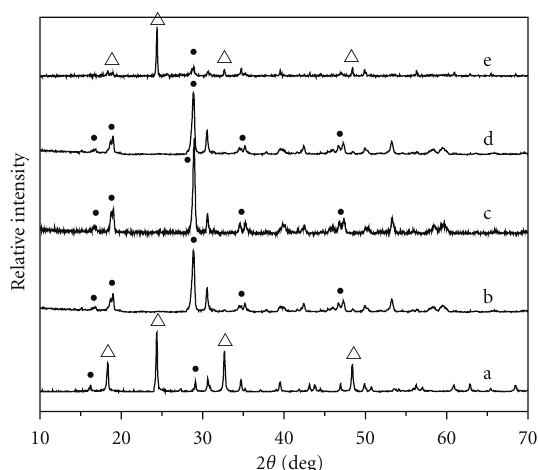
Figure 2: XRD patterns of samples under di ff erent pH. ( (cid:3) — tetragonal zircon type, • —monoclinic scheelite type). (a) pH = 1.0, (b) pH = 3.0, (c) pH = 5.0, (d) pH = 7.0, (e) pH = 10.0. Table 1: Crystal size of samples di ff erent pH at 110 ◦